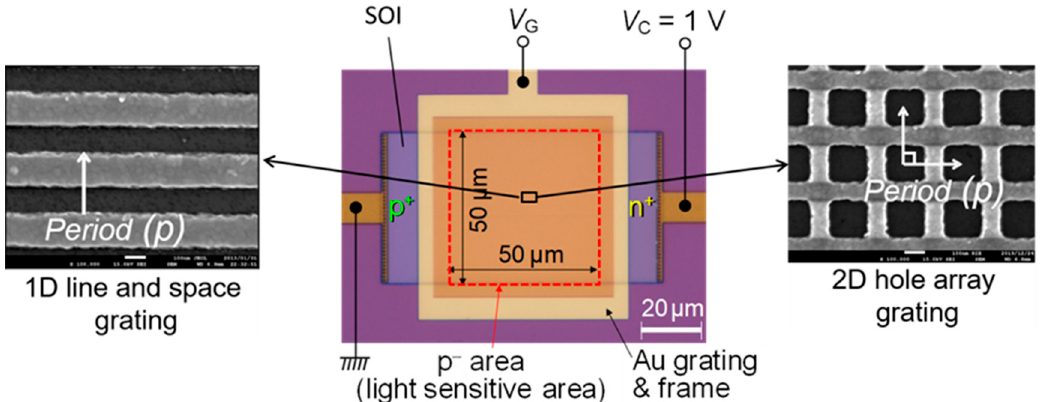
Figure 2. Top view (optical and scanning-electron micrographs) of the fabricated device with the 1D line and space grating and a 2D hole array grating reproduced from [22].